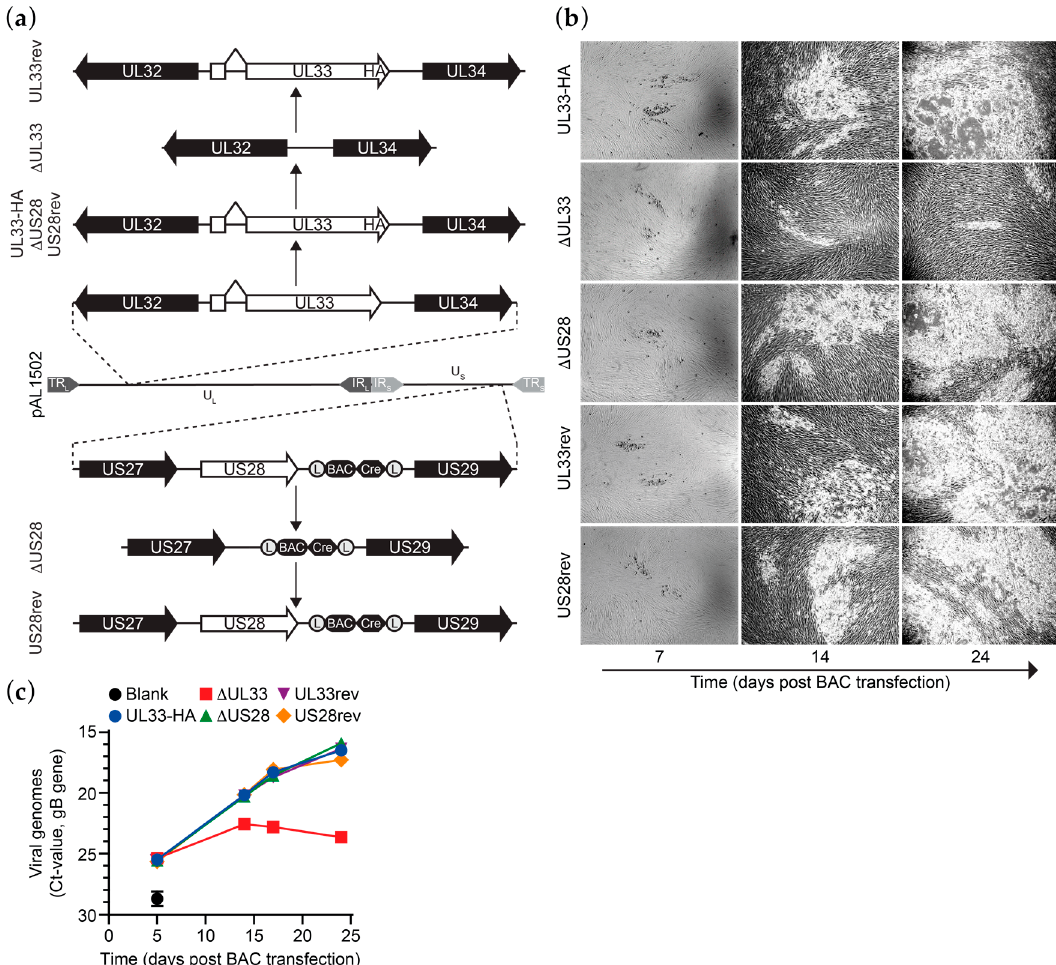
Figure 1. UL33 facilitates Human cytomegalovirus (HCMV) Merlin virus growth in vitro. ( a ) Schematic representation of the recombination strategy to construct HCMV Merlin mutant BACs. Designations of the BAC variations are shown on the left. TR, terminal repeat; IR, internal repeat; U, Unique region; L , long; S , short; (L), loxP sites; BAC, pBeloBAC11; Cre, Cre recombinase; ( b ) micrographs of HCMV virus growth in HFFF TR cells upon reconstitution of the di ff erent HCMV Merlin mutants via transfection of the cells with BAC DNA; micrograph size: 2.2 mm × 1.64 mm; ( c ) multistep growth kinetics of Merlin-UL33-HA and mutant viruses, as assessed by the number of secreted virus particles. Results are representative of 3 individual experiments and depicted as mean and SD.